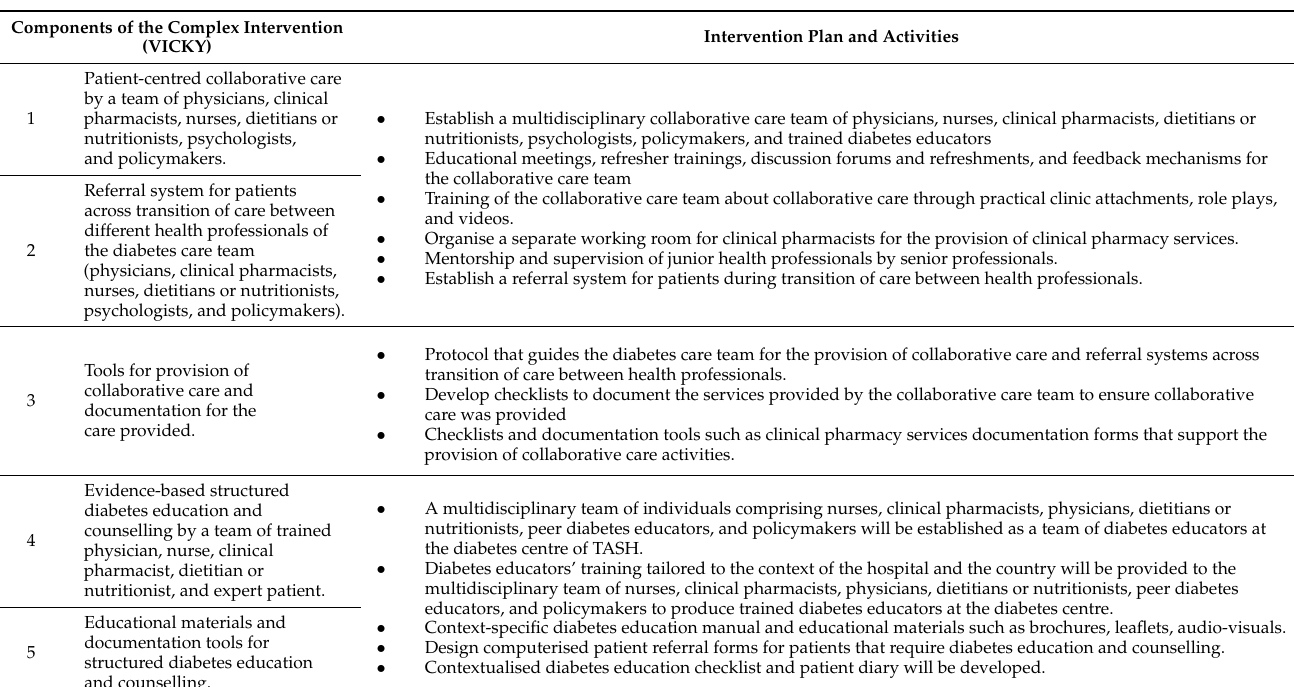
Table 1. Components and intervention plan of the complex (VICKY)